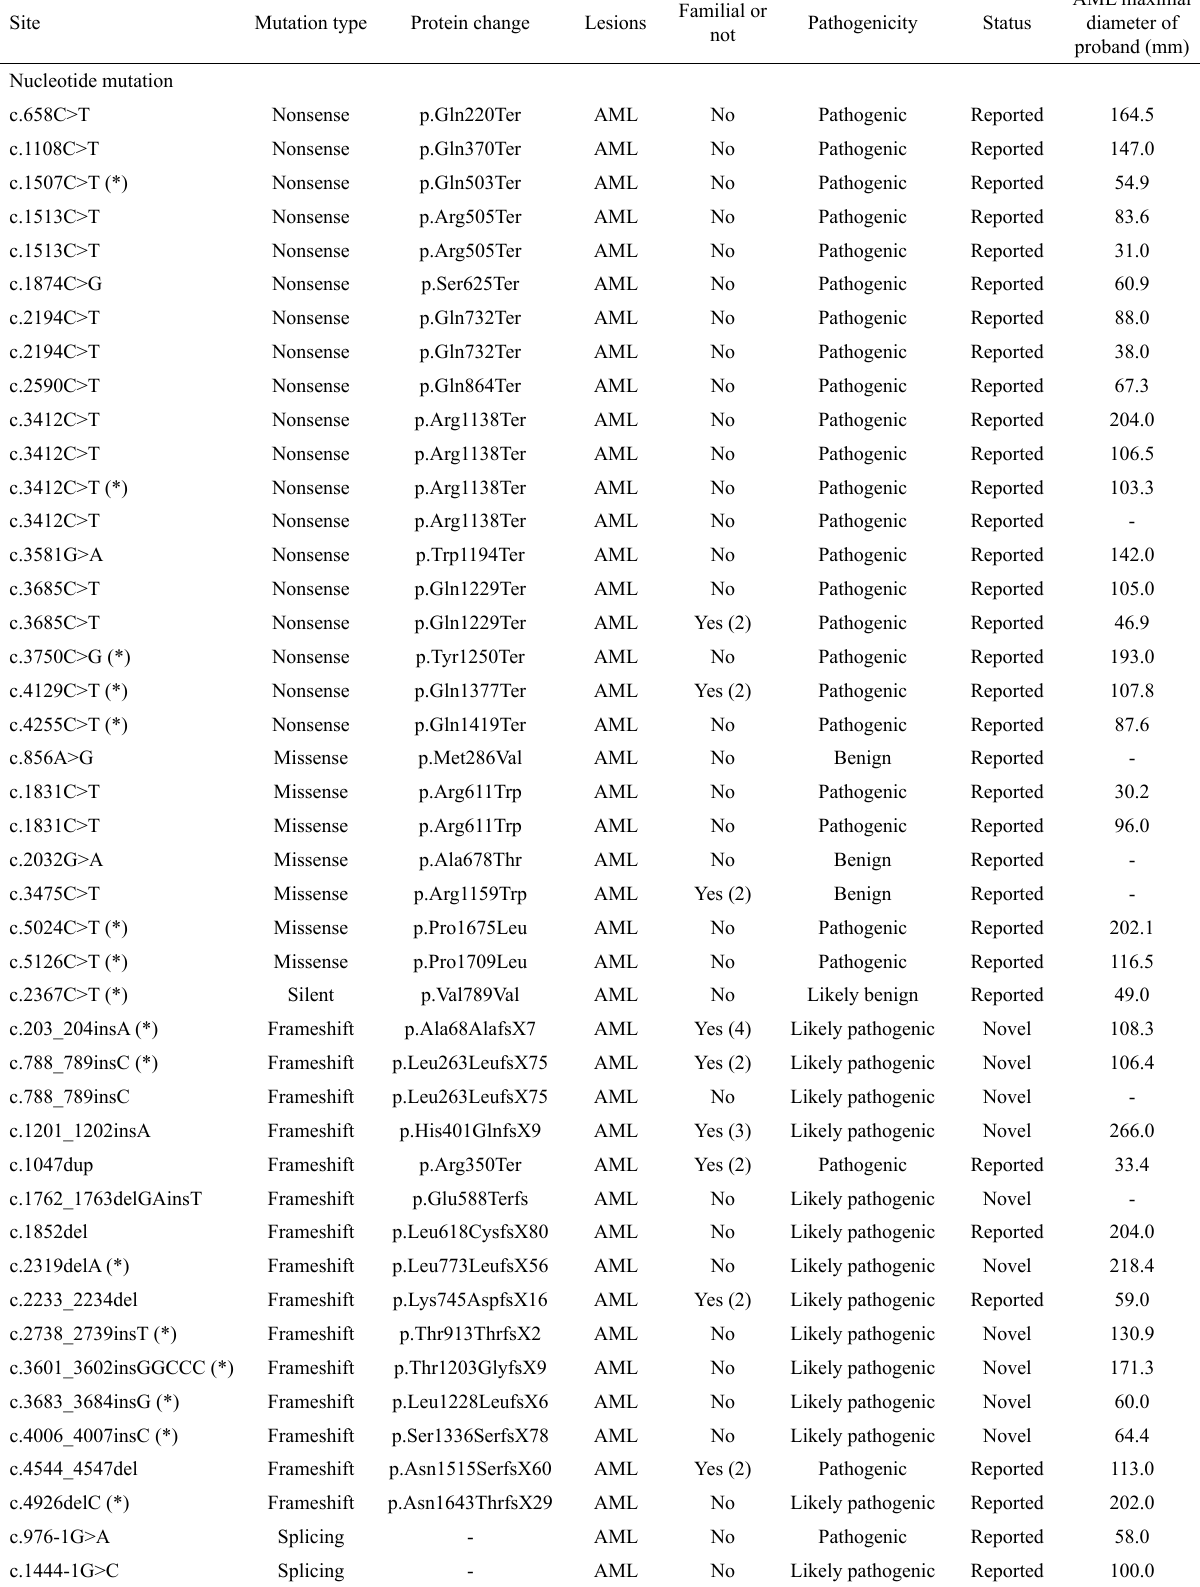
Table 4 - TSC2 gene mutation